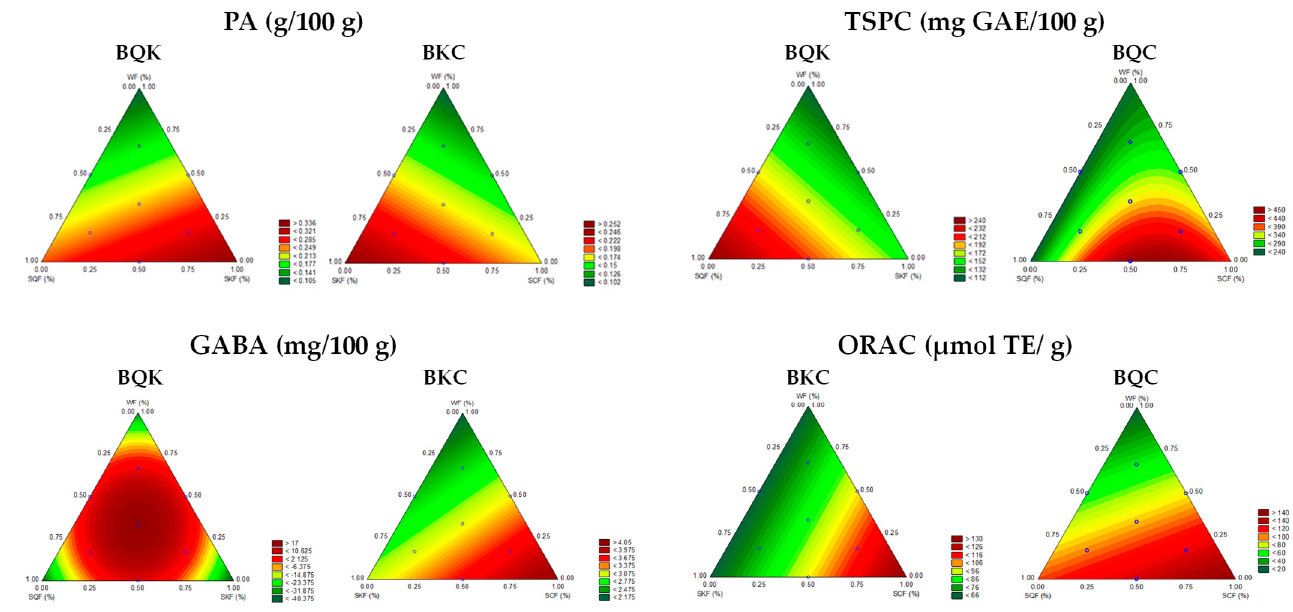
Figure 2. Contour plots of predicted PA, GABA, TSPCs, and ORAC where X 1 , X 2 , and X 3 are normalized to 100%. Abbreviations: BQK, biscuits formulated with sprouted quinoa (X 1 ), sprouted kiwicha (X 2 ), and wheat flour (X 3 ); BQC, biscuits formulated with sprouted quinoa (X 1 ), sprouted cañihua (X 2 ), and wheat flour (X 3 ); BKC biscuits formulated with sprouted kiwicha (X 1 ), sprouted cañihua (X 2 ), and wheat flour (X 3 ); GABA, γ -aminobutyric acid; GAE, gallic acid equivalents; ORAC, oxygen radical absorbance capacity; PA, phytic acid; TSPCs, total soluble phenolic compounds; TE: Trolox equivalents.